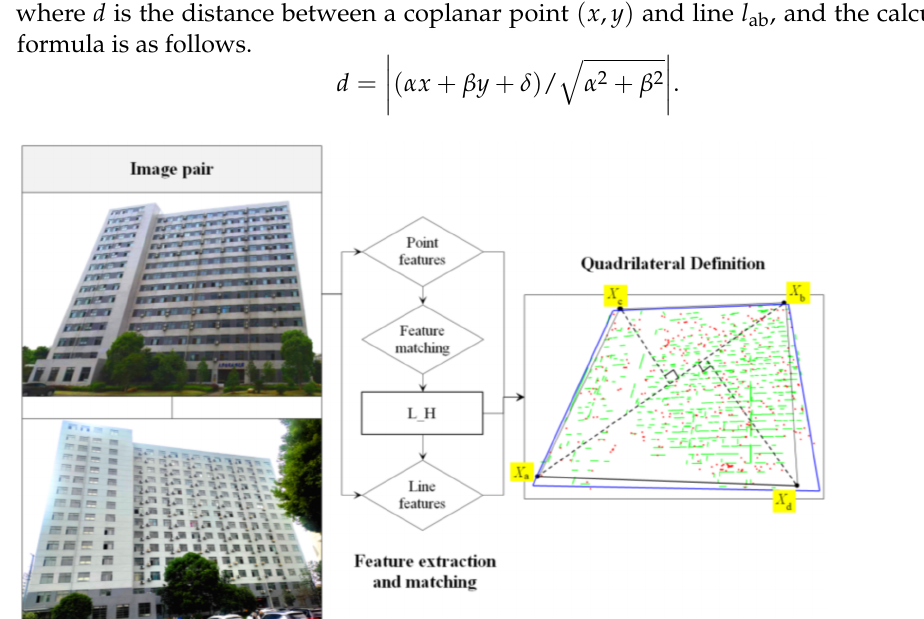
Figure 6. Initial quadrilateral definition of a plane. The red and green dots denote the corresponding points obtained from point features and line features, respectively. Blue lines represent the ground truth of the boundary of a façade, and the black line is the initial quadrilateral